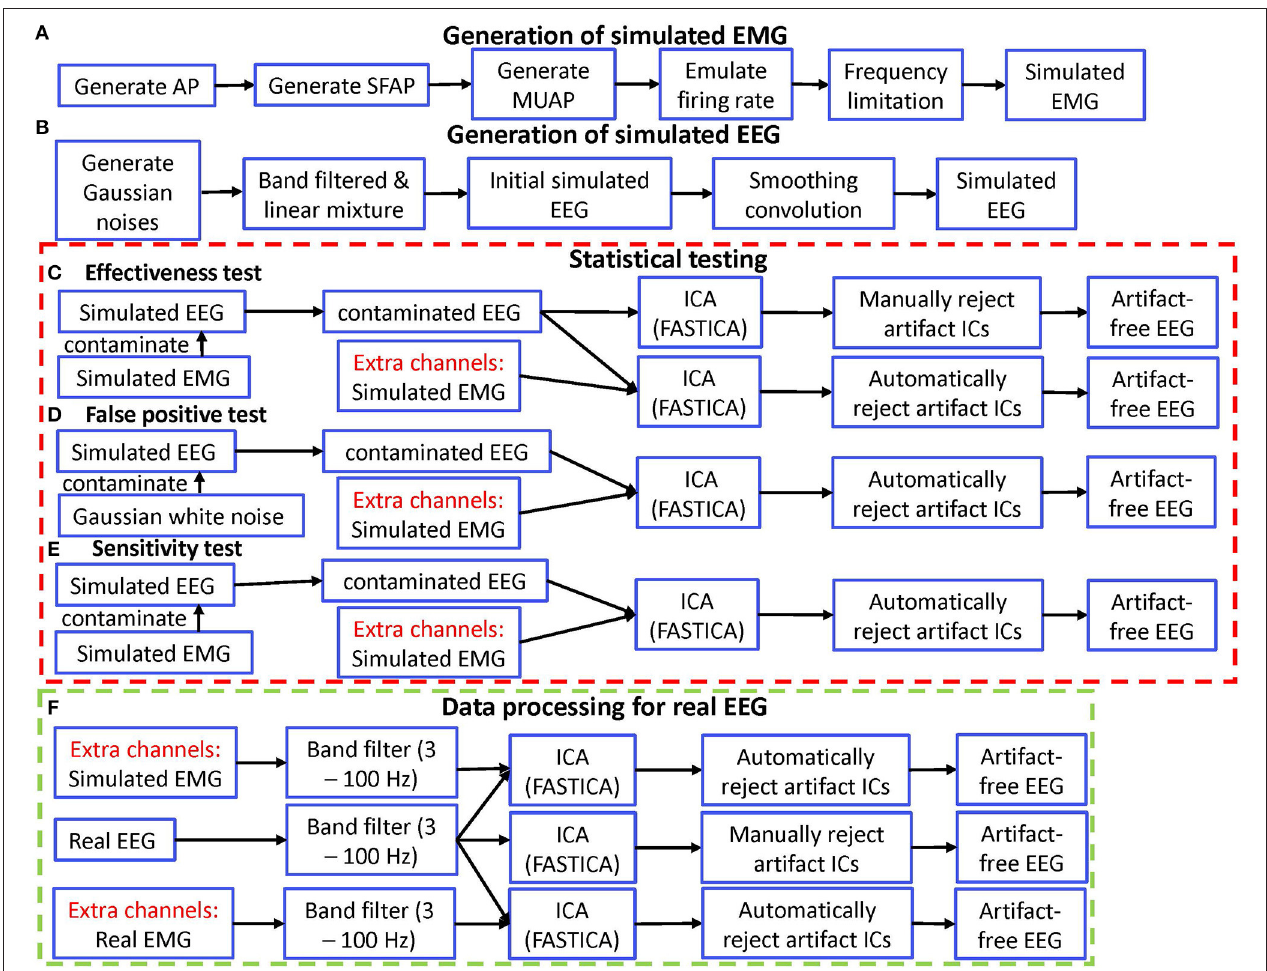
FIGURE 1 | Diagram of simulation validation for ERASE. (A) Diagram for generating simulated EMG. (B) Diagram for generating simulated EEG. (C) Diagram for effectiveness test. (D) Diagram for false positive test. (E) Diagram for sensitivity test. (F) Diagram for data processing of real EEG. AP, action potential; SFAP, single fiber action potential; MUAP, motor unit action